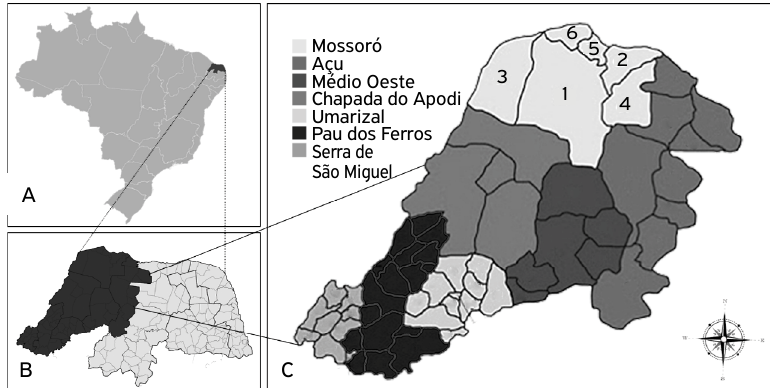
Figure 1. Map of Brazil highlighting the state of Rio Grande do Norte and enlargement of the cities where 467 animals were surveyed, distributed in 18